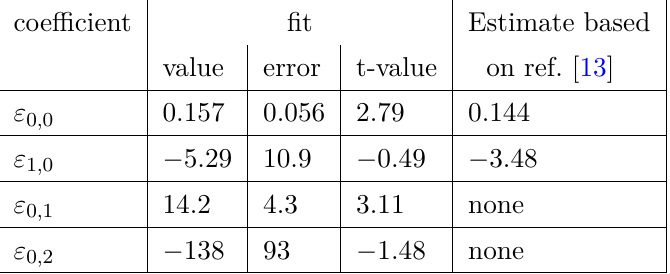
Table 4 . Simultaneous large N and continuum fit for T = 0 . 25 , µ = 0 . 5 . All other coefficients in (5.1) are set to zero. Residual standard error: 1.13 on 8 degrees of freedom. Data includes unconstrained simulations at N = 16 and constrained simulations at N = 18 , 21 . A Kolmogorov-Smirnov test as in figure 13 is passed successfully, showing that the fitting ansatz describes the data well. We restricted to only first-order corrections in 1 /N 2 due to using N ≥ 16 and omitted ε 1 , 1 as it was estimated to be very small at T = 0 . 3